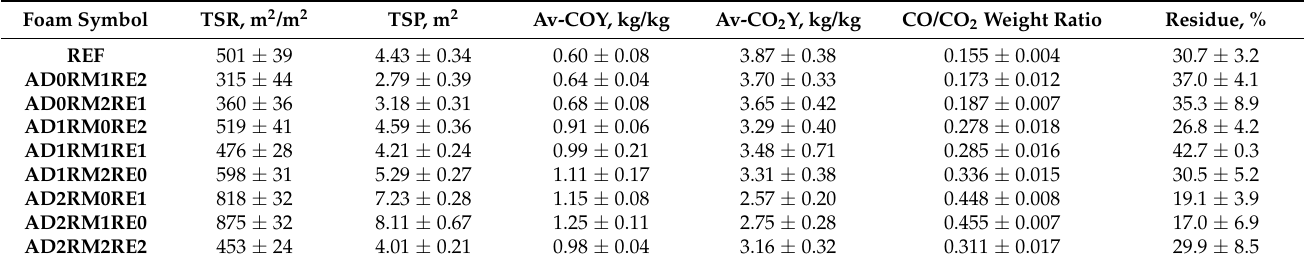
Table 8. Smoke emission parameters of the obtained polyurethane